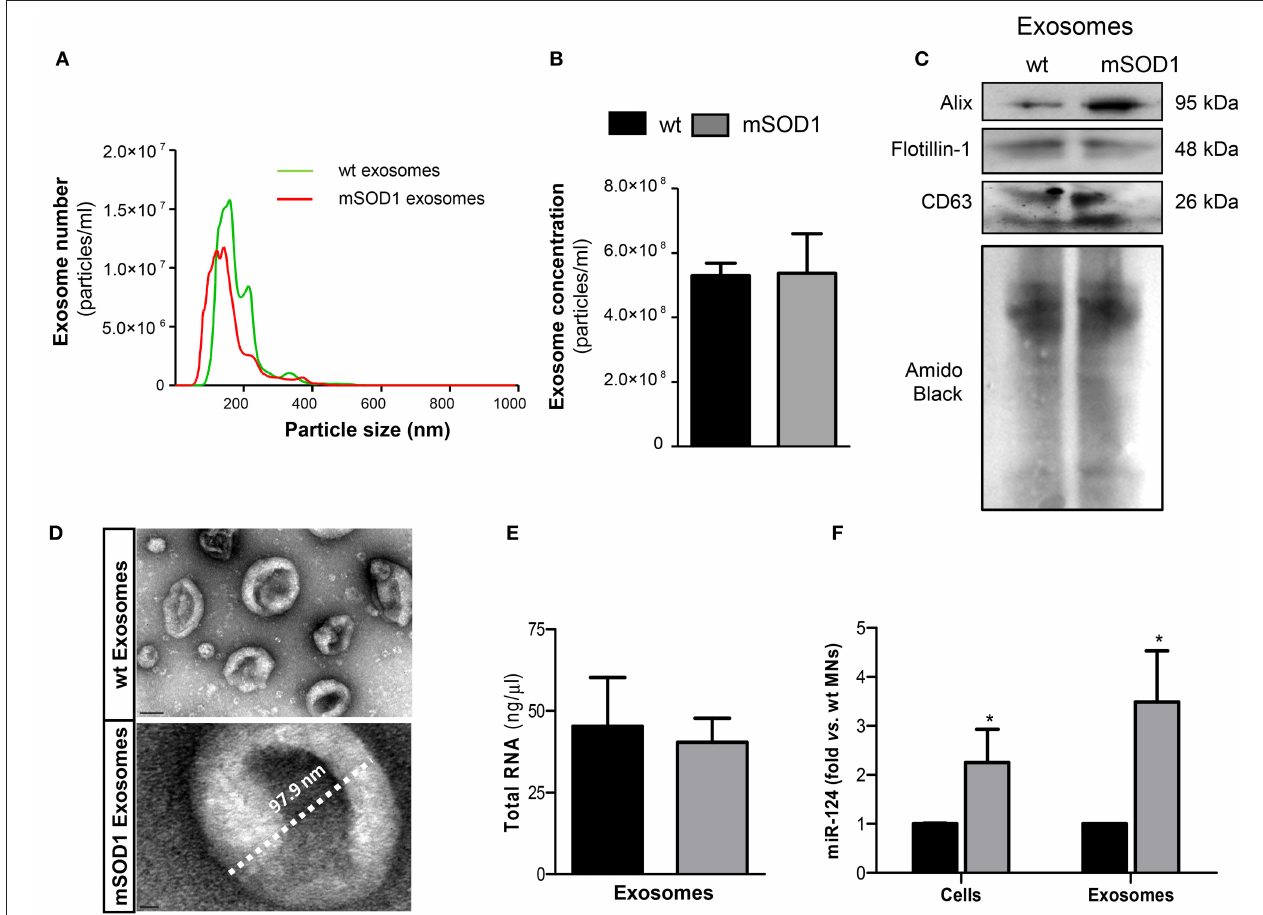
FIGURE 1 | Exosomes released by wild-type (wt) SOD1 NSC-34 motor neurons (MNs) and by those mutated in G93A (mSOD1) show similar number, size and total RNA content, but only mSOD1 NSC-34-derived exosomes display elevated expression of microRNA (miR)-124, thus recapitulating the donor cell. Exosomes were isolated from the extracellular media of NSC-34 cells, either human wild-type SOD1 (wt MNs) or mutated in G93A (mSOD1 MNs), after 4 days in vitro differentiation, as described in methods. (A,B) Evaluation of the nanoparticles (exosomes) size and density by NTA indicates that the majority of vesicles from MNs have diameter ∼ 130 nm, with no differences between wt and mSOD1 NSC-34 MNs in terms of particle concentration. (C) Western blot analysis indicates the presence of common exosome markers (Alix, Flotillin-1, and CD63). (D) Representative images obtained by transmission electron microscopy (TEM) of exosomes are depicted evidencing cup shape morphology and protein clusters. (E,F) RNA was extracted from cells and exosomes to evaluated microRNA (miRNA) expression. Quantification of total RNA (E) revealed no differences between samples from wt and mSOD1 NSC-34 MNs, while (F) miRNA profile show an increase only in miR-124 in both mSOD1 cells and in their derived exosomes. Results are mean ( ± SEM) from at least five independent experiments. Differences between mSOD1 NSC-34 MNs and wt NSC-34 MNs in cells and exosomes were obtained by the two-tailed Student’s t -test with Welch’s correction. * p < 0.05 vs. respective wt MNs (Control). Scale bar represents 100 nm in exosomes from wt NSC-34 MNs and 10 nm in mSOD1 NSC-34